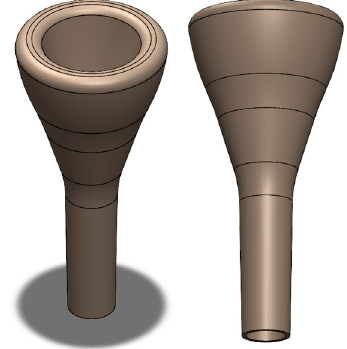
Figure 3. 3D CAD model of the mouthpiece.